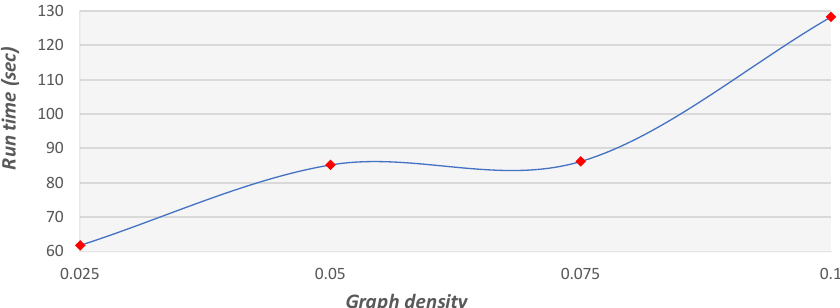
Figure 23. Run time of the GA on graphs with 8000 vertices at different densities.